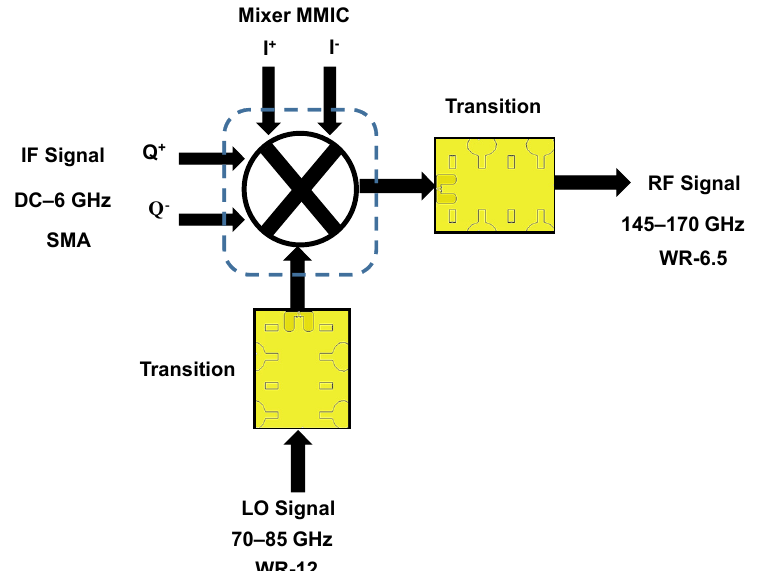
Figure 12. Block diagram of the IQ subharmonic up-mixer.